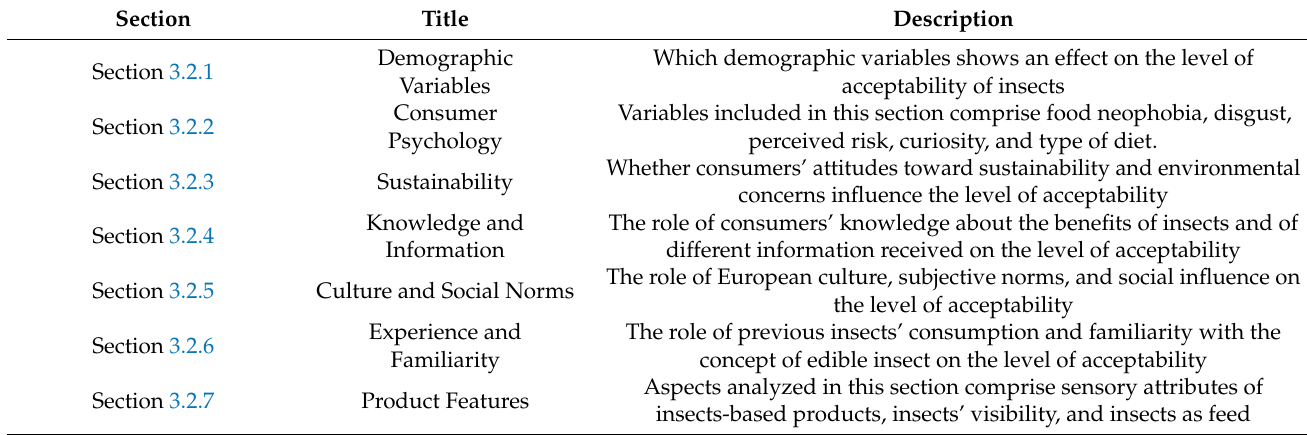
Table 3. Summary of aspects analyzed in this